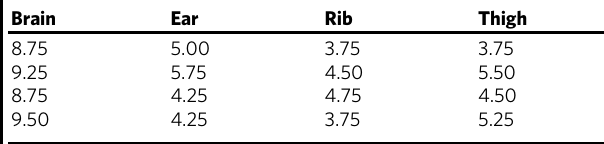
Table 1 Comparison of prion-seeding activity between brain Table 2 Comparison of prion-seeding activity between and skin of infected hamsters (LogSD 50 /mg tissue)* Brain (FC) Hamster (12 wpi)